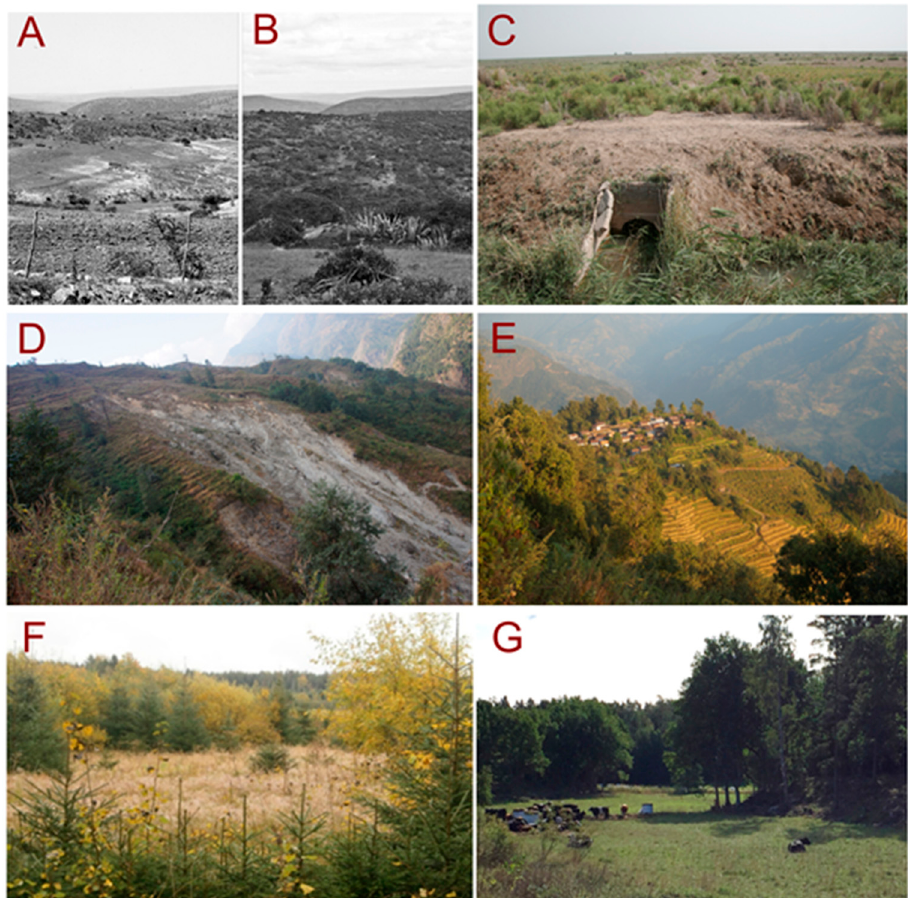
Figure 3. Examples of abandoned fields, including ones covered in the Special Issue. ( A , B ) Repetitive photos for the Gawukeni location (former Ciskei, South Africa) in support of [11], photographed by Comins in 1956 ( A ) and then photographed by Puttick in 2011 ( B ) (source: repetitive photography project of South African Landscapes http://rephotosa.adu.org.za/Search_photos.php). ( C ) Example of abandoned fields in Karakalpakstan, Uzbekistan (credit: Fabian Löw) [19]. ( D ) Degraded abandoned terraces in Nepal; ( E ) a mix of cultivated and abandoned terraces also in Nepal [4,9,10] (credit: Suresh Chaudhary). ( F ) Cropland abandonment in Sweden (credit: Karl-Ivar Kumm) [13]. ( G ) Organic cattle production as an alternative to cropland abandonment in Sweden(credit: Mikaela Jardstedt) [13].